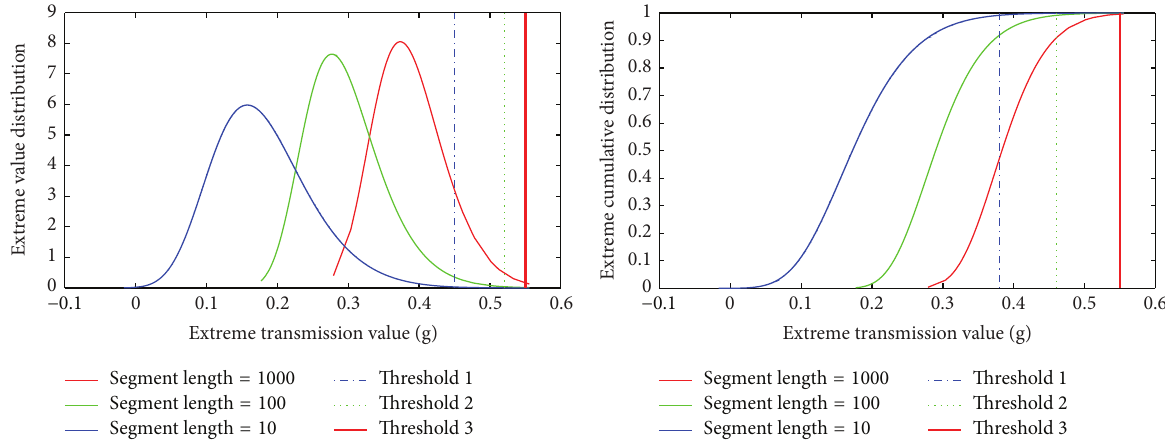
Figure 1: Extreme value distribution with relative threshold affected by segment length